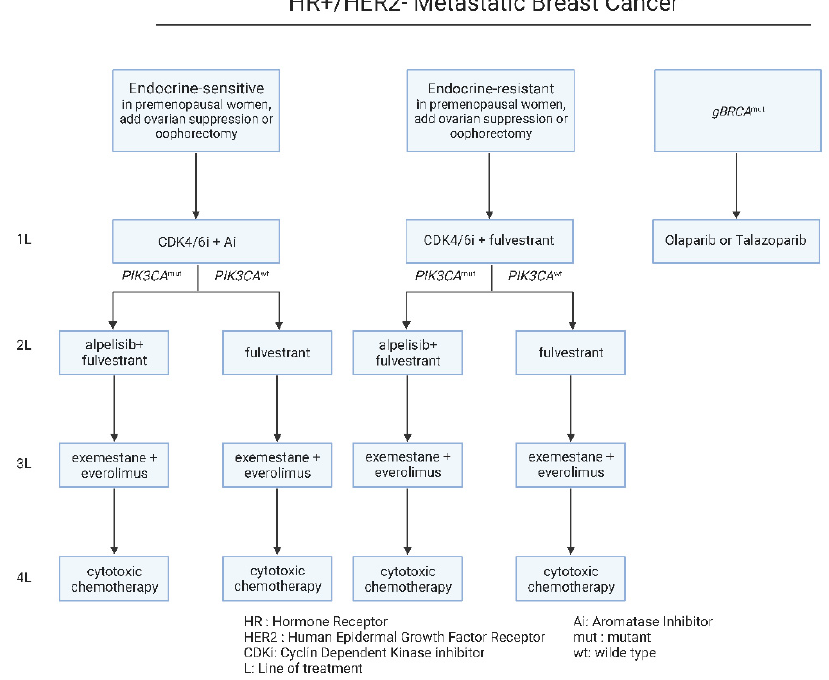
Figure 3. Current therapeutic algorithm for the management of HR + /HER-2 − mBC. Proposed therapeutic algorithm for patients with HR + /HER-2 − metastatic breast cancer [39]. The abbreviations of the terms used in the figure are outlined in the lower part of the algorithm.